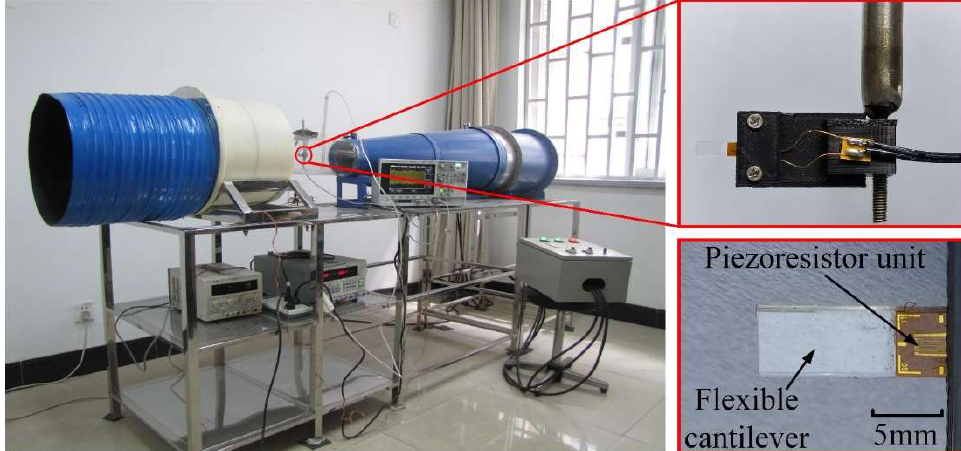
Figure 3. Schematic diagram of the measurement setup and the photograph of the fabricated microcantilever anemometer prototype.